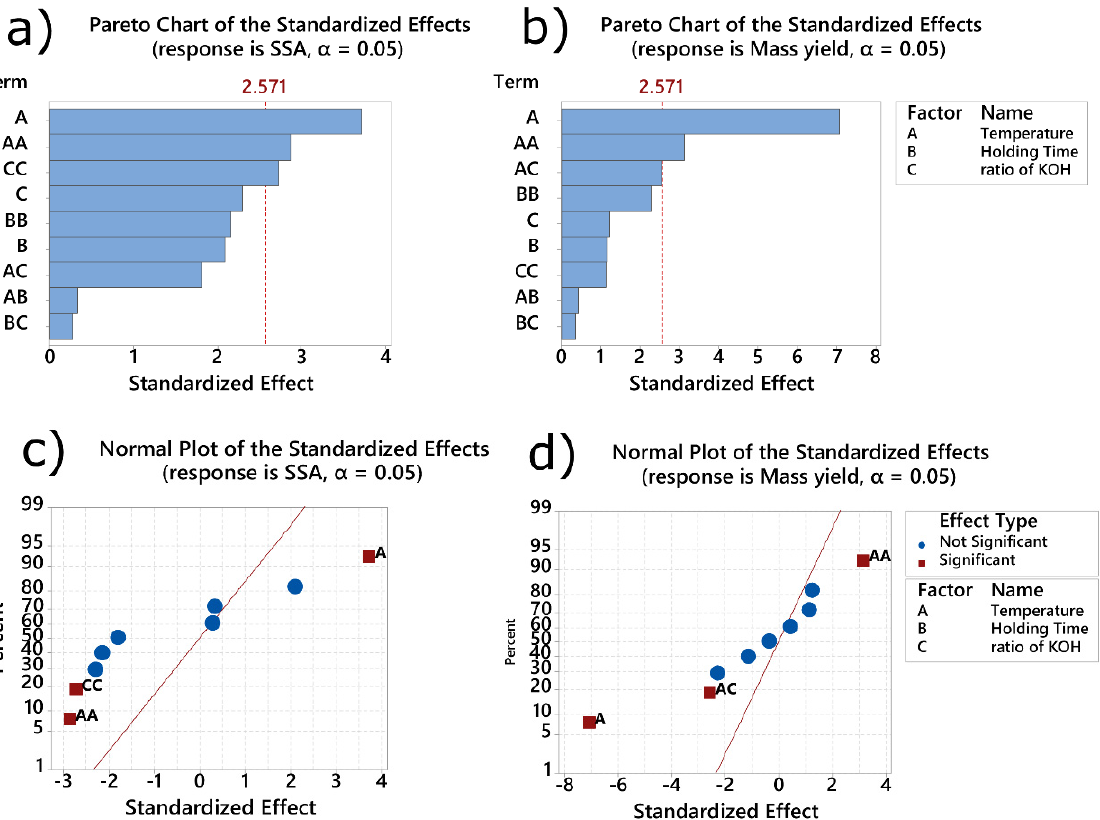
Figure 1. Normal plot for standardized effects: ( a ) SSA; ( b ) mass yielding. Pareto chart for: ( c ) SSA; ( d ) mass yielding.